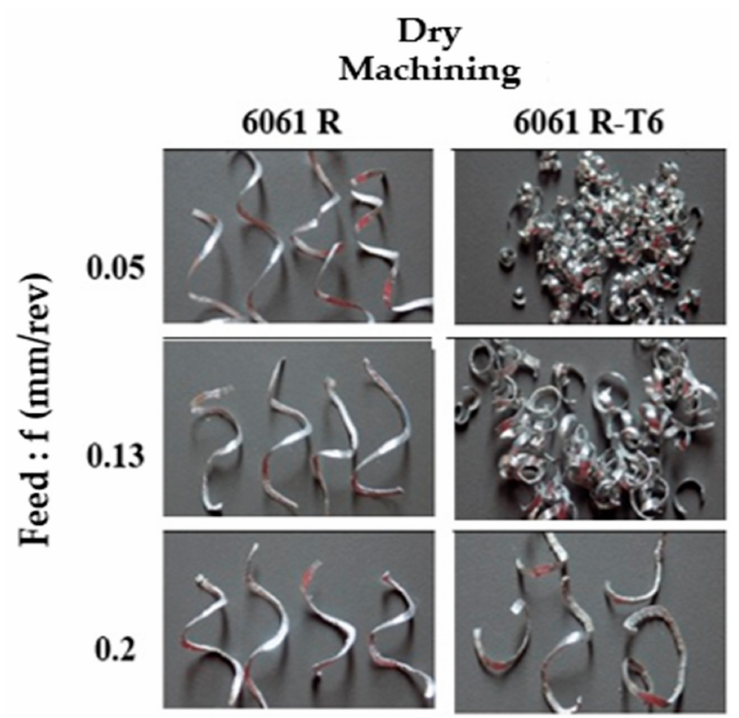
Figure 10. Morphology of chips of recycled alloys 6061 R and 6061 R-T6 dry